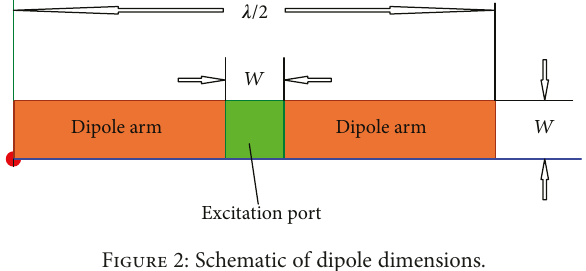
Figure 2: Schematic of dipole dimensions.